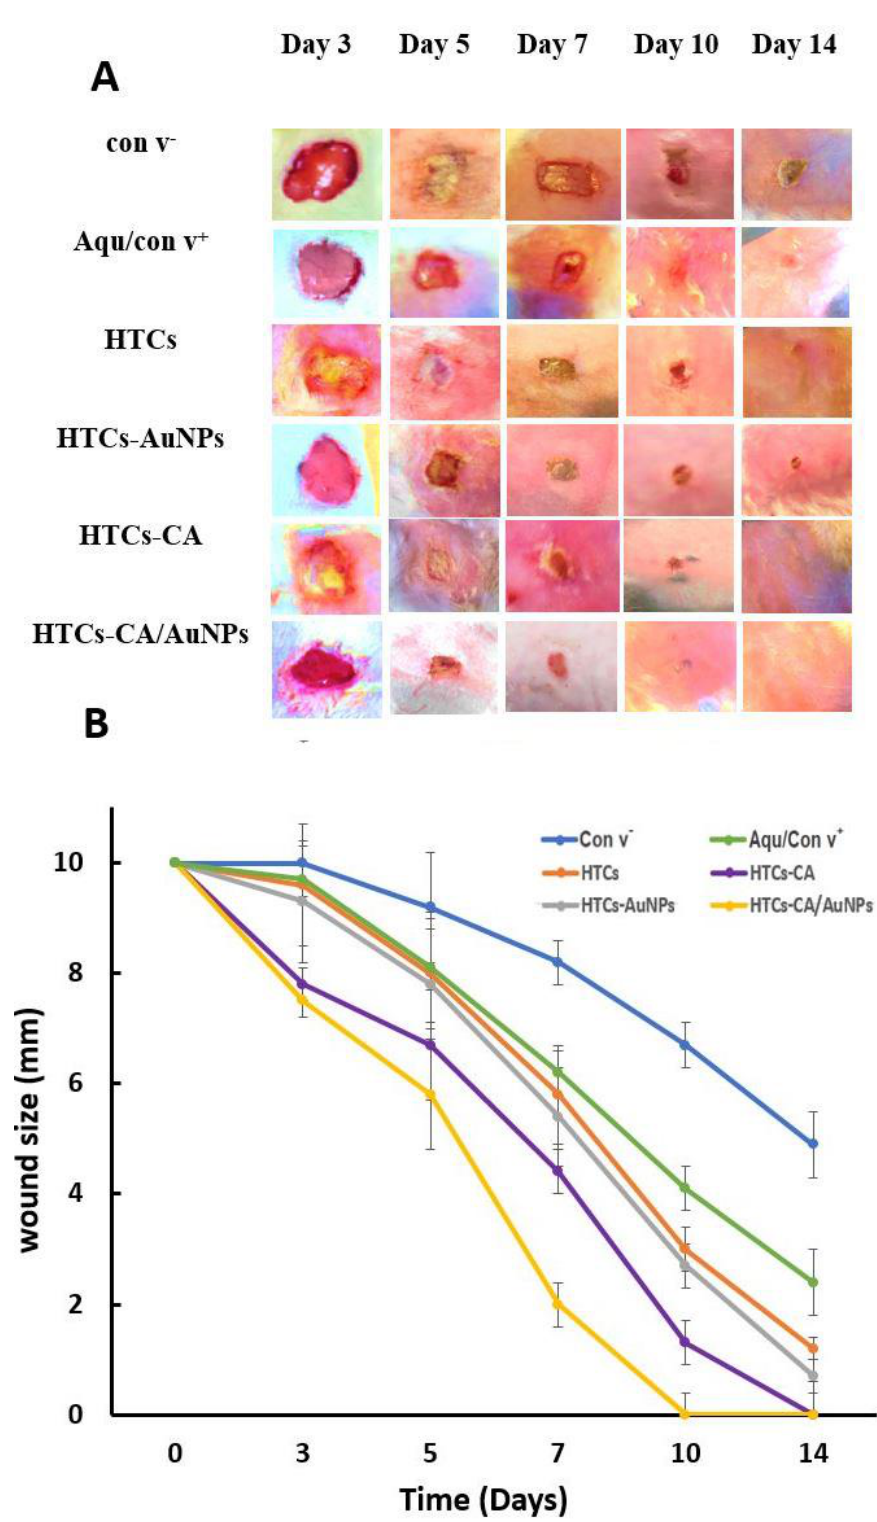
Figure 5. Photographic pictures of wound healing process ( A ) Changes curve of the wound size ( B ) on days 0, 3, 5, 7, 10, and 14 for the all dressings HTCs, HTCs-capsaicin, HTCs-AuNPs and HTCs-capsaicin / AuNPs in addition to the negative (con v-) and positive (Aquacel ® Ag) control. (CA refers to capsaicin).